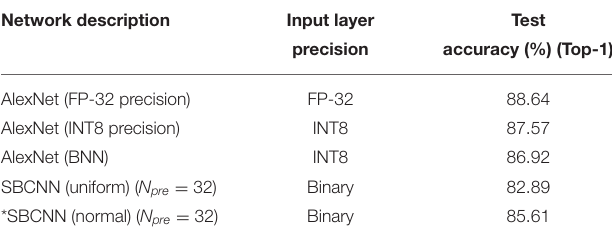
TABLE 2 | Test accuracy benchmarking of different precision networks, simulated in this study, for CIFAR-10 dataset. Network description